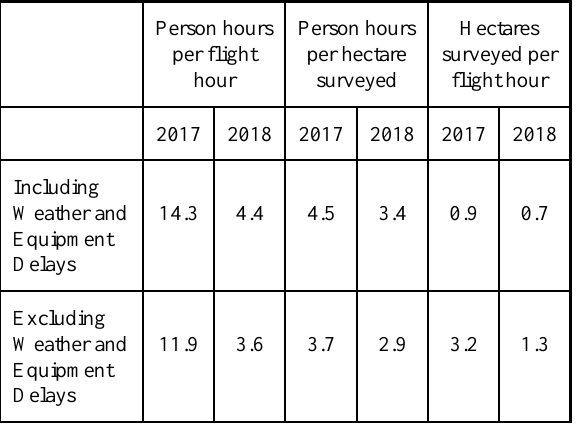
Table 3. Levels of effort required to conduct one flight hour, map one hectare of land, and area surveyed per hour. 2.5.3 Data Quality was high both years with LiDAR returns from vegetation subcanopy features and ground. Obtaining a achieved (Fig 4).